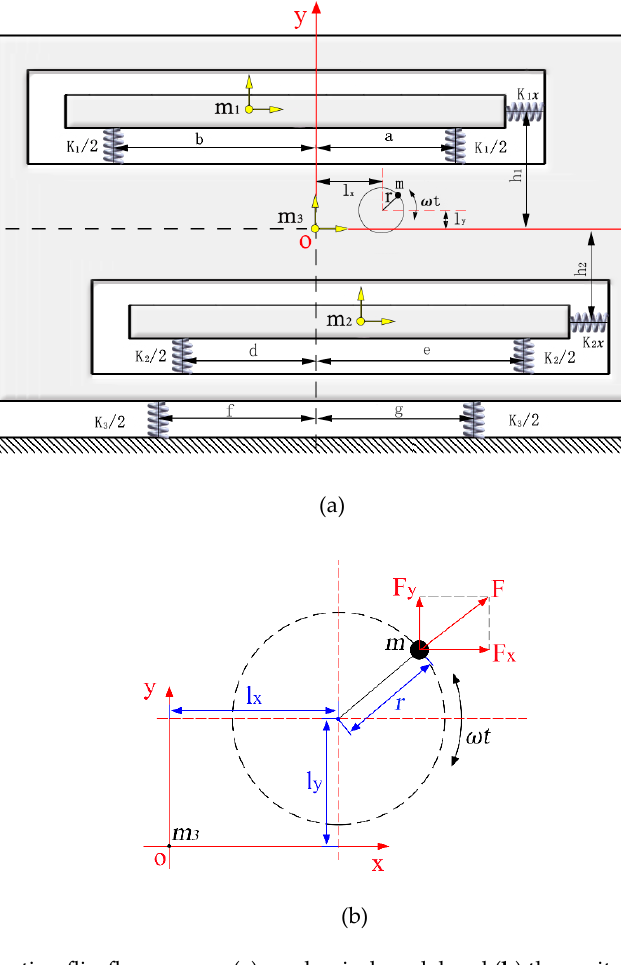
Figure 3. Double-deck vibrating flip-flow screen: ( a ) mechanical model and ( b ) the excitation force and the components.